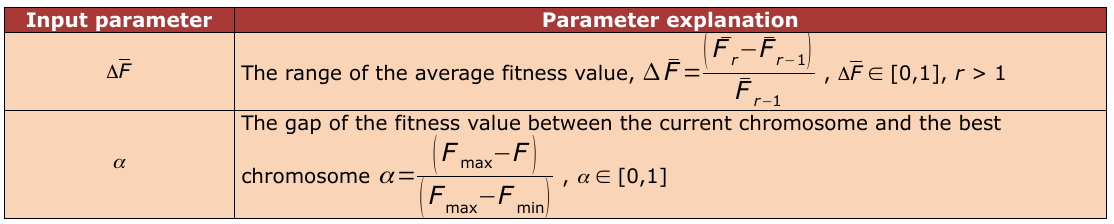
Table 3. Input parameters of fuzzy logic